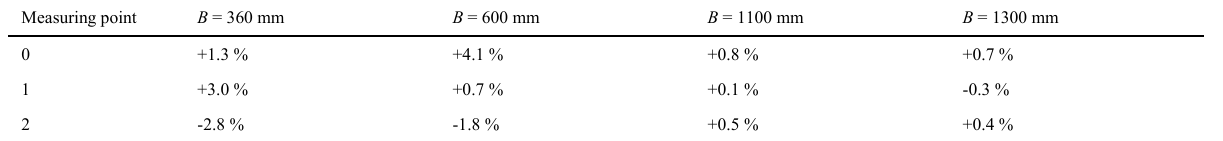
Table 3: Deviation of the numerically calculated longitudinal strain from the measured values at σ bth = 63 N/mm 2 . Measuring point B = 360 mm B = 600 mm B = 1100